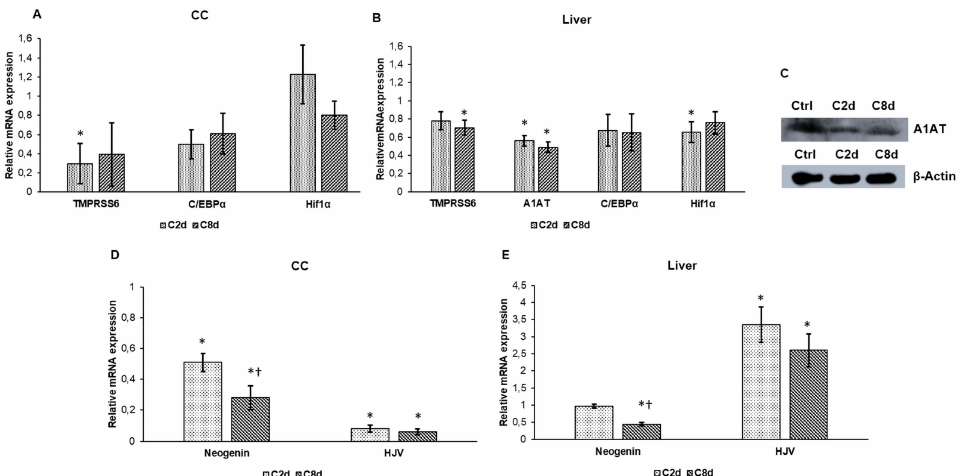
Figure 3. Expression analyses of hepcidin regulatory genes in CZ-treated groups. Real Time PCR was performed with SYBR green protocol using gene specific primers. Relative expression of controls was regarded as 1. Western blot analysis was done from protein extracts of the liver tissue samples. The same amount of protein (10 µ g) from each sample was loaded onto 10% SDS-PAGE and transferred by electro blotting to nitrocellulose membranes and probed with A1AT polyclonal rabbit antibody